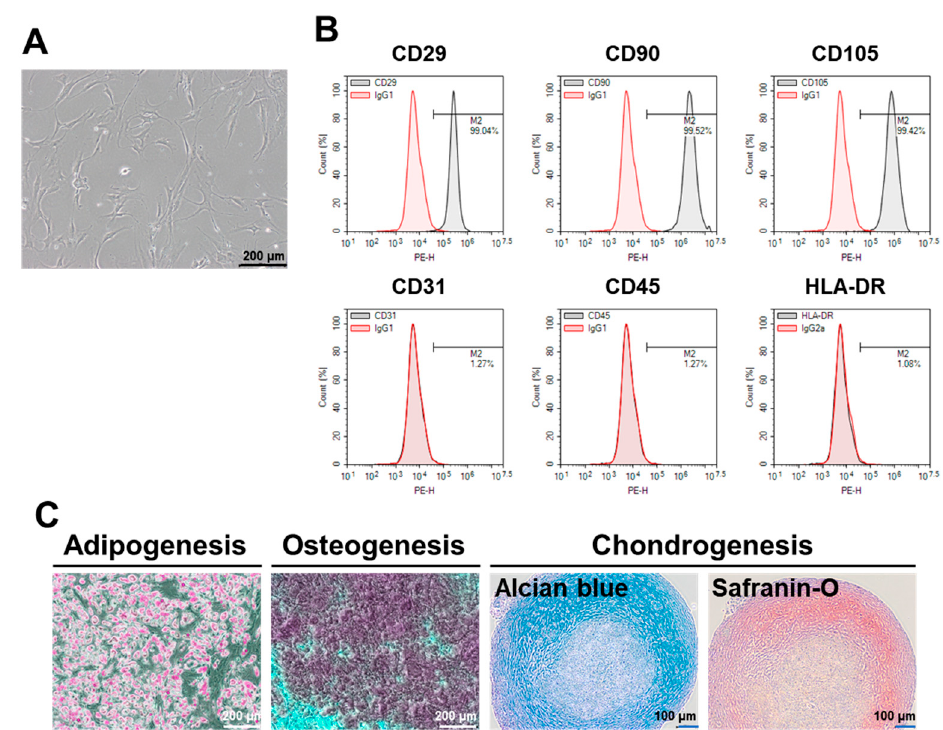
Figure1. Characteristicsofhumanadiposetissue-derivedMSCs(ASCs). ( A )Representativemicroscopic Figure 1. Characteristics of human adipose tissue-derived MSCs (ASCs). ( A ) Representative imageofculturedASCsdemonstratingtypicalspindle-orfibroblast-likemorphology. ( B )Representative microscopic image of cultured ASCs demonstrating typical spindle- or fibroblast-like morphology. flow cytometry (FCM) data showing the expression of mesenchymal stem / stromal cells (MSC) positive ( B ) Representative flow cytometry (FCM) data showing the expression of mesenchymal stem/stromal markers (Cluster of Di ff erentiation 29 (CD29), CD90, and CD105) and the absence of negative markers cells (MSC) positive markers (Cluster of Differentiation 29 (CD29), CD90, and CD105) and the absence (CD31, CD45, and human leukocyte antigen—DR isotype (HLA-DR)). ( C ) Representative results of negative markers (CD31, CD45, and human leukocyte antigen – DR isotype (HLA-DR)). ( C ) showing trilineage di ff erentiation of ASCs. Adipocytes, osteocytes, and chondrocytes were detected by Representative results showing trilineage differentiation of ASCs. Adipocytes, osteocytes, and Oil Red O, Alizarin red, and Alcian blue and Safranin O staining, chondrocytes were detected by Oil Red O, Alizarin red, and Alcian blue and Safranin O staining, respectively.